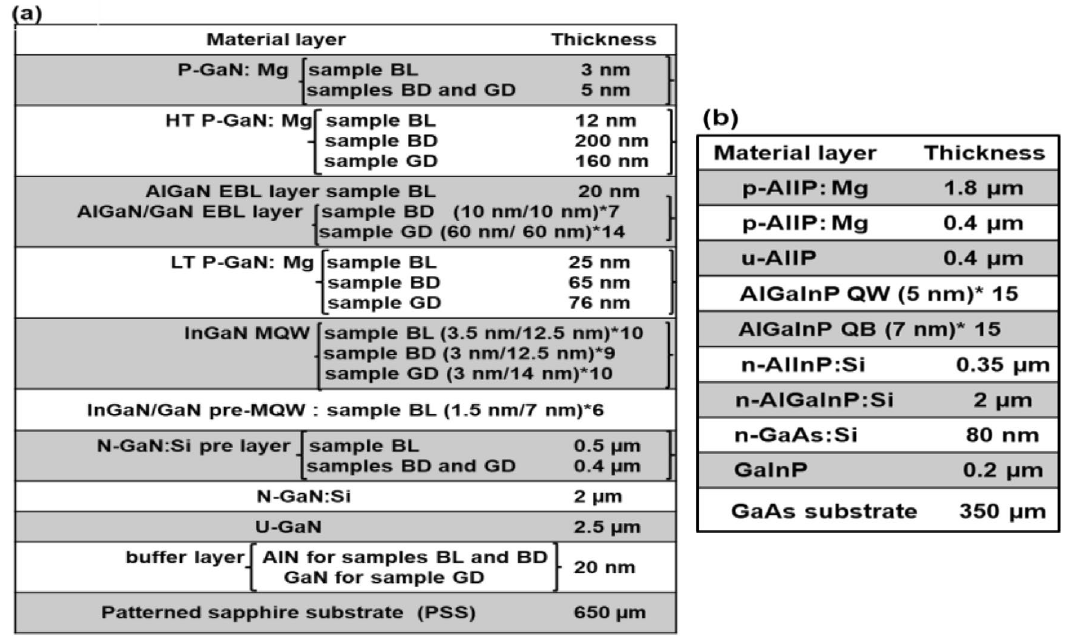
Figure 6. ( a ) A schematic diagram of the InGaN/GaN MQW LED epitaxial structure: BL, BD, and GD. ( b ) A schematic diagram of RD MQW LED epitaxial